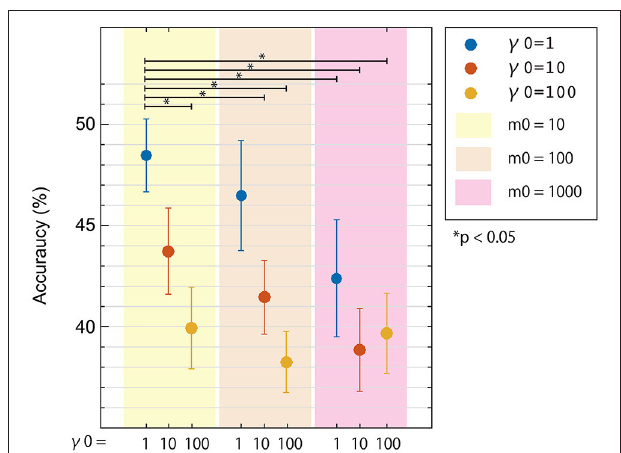
FIGURE 3 | Three-class classification accuracies of EEG cortical current signals obtained from inverse filters with different hyper-parameters. Results using a prior magnification parameter m 0 = 10 , 100 , and 1000 are denoted as yellow, cream, and pink areas, respectively. Results using prior reliability parameters γ 0 = 1 , 10 , and 100 are denoted as blue, red, and yellow dots, respectively. All conditions used the same fMRI area/activity priors from Unc001. Error bars denote standard error. Statistical differences were calculated using non-parametric permutation